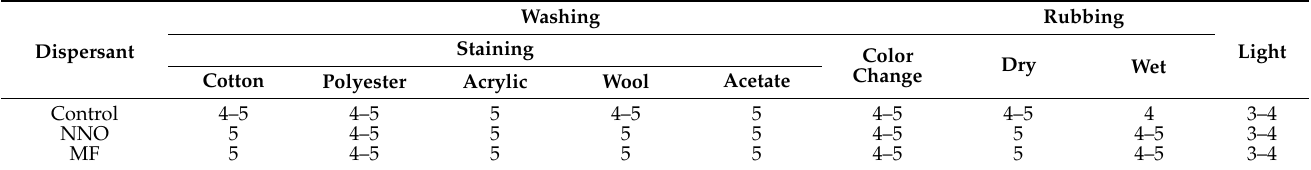
Table 2. Influence of dispersant on the dyed polyester fabrics dyed color fastness in silicone waterless dyeing